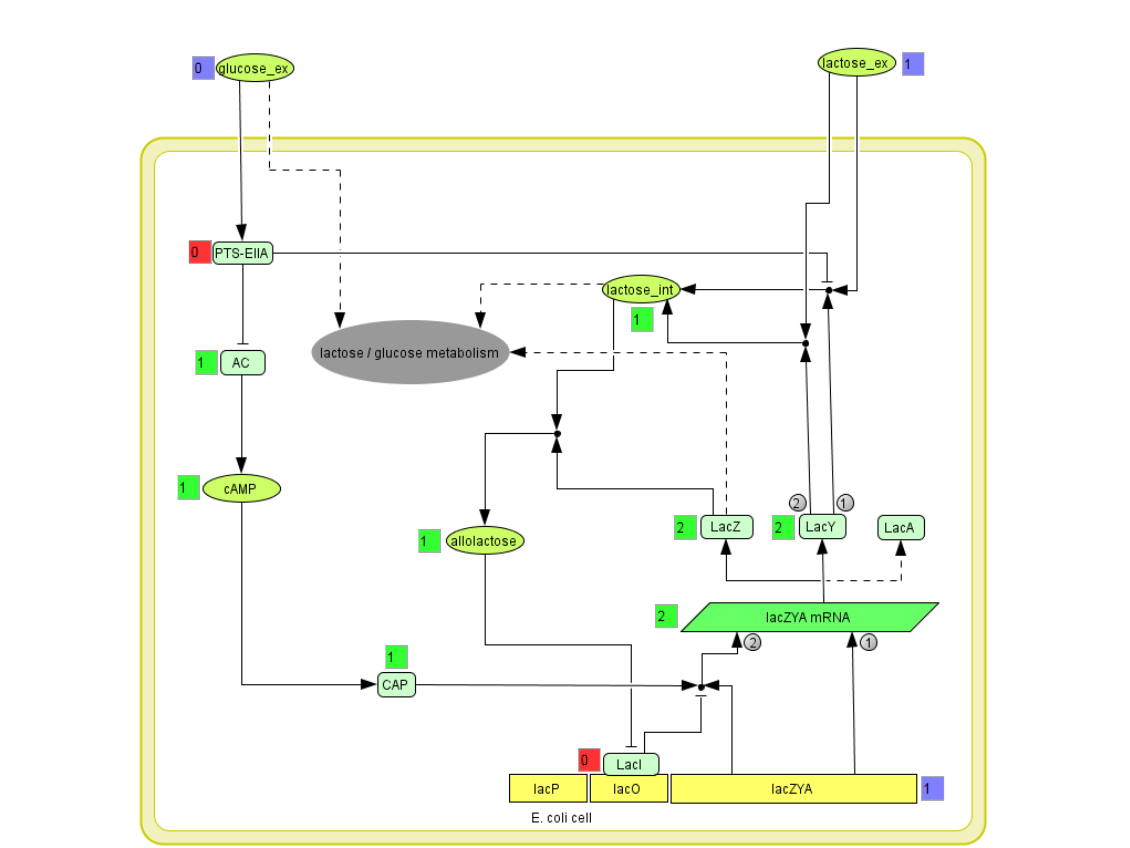
Figure 3: The multivalued logical model for the lac operon (screenshot from CellNetAnalyzer ). The text boxes show the resulting logical steady state for the scenario -glucose/+lactose switching the lac operon fully on (level 2). For the colour-code of the boxes see figure 3. The numbers in the grey circles denote the level of multivalued nodes in the respective